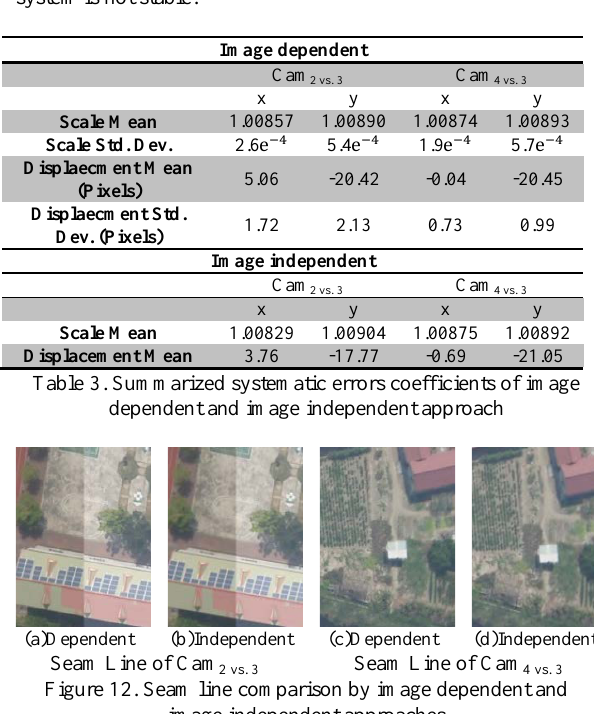
Seam Line of Cam 4 vs. 3 Figure 12. Seam line comparison by image dependent and image independent approaches